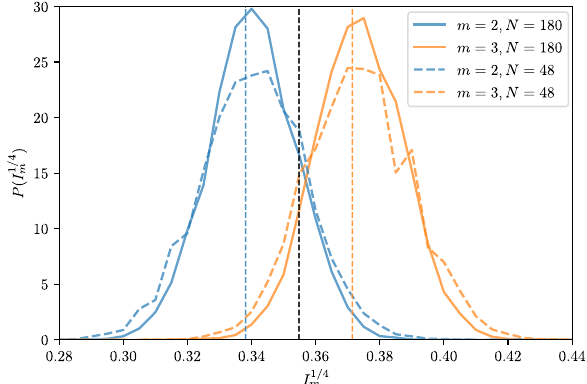
FIG. 4. Probability distribution of I 1 = 4 m for N=m GOE blocks with m ¼ 2 (blue) and m ¼ 3 (orange). Histograms are obtained from 20 000 values, each of which is calculated from 40 realizations of matrices of size N ¼ 180 (solid lines) and from 120 realizations for size N ¼ 48 (dashed lines). Vertical blue and orange lines indicate the theoretical predictions for m ¼ 2 and 3, I 1 = 4 2 þ I 1 = 4 3 Þ respectively; the blue line is the mid-value 1 2 ð